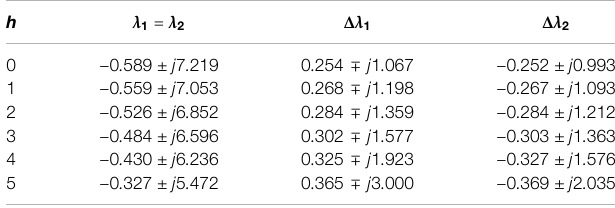
TABLE 3 | Calculation results when Z 3 increases.